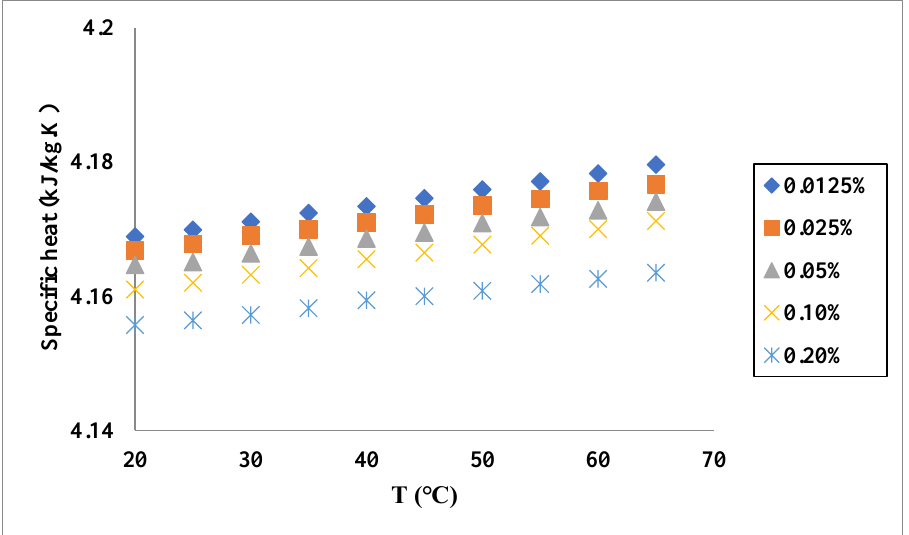
Figure 6. SH variation with temperature of Cu-Al 2 O 3 /water for different solid fractions. Adapted from Ref. [62].